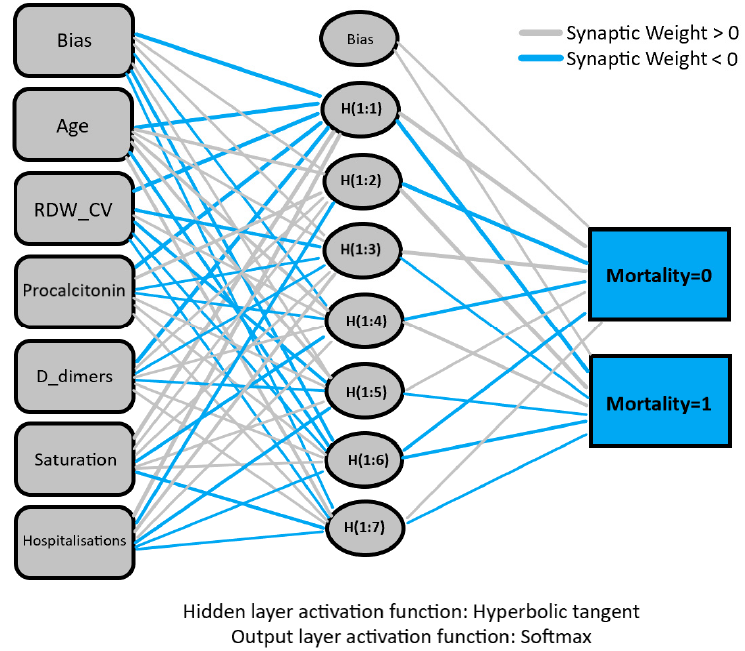
Figure 2. Network diagram acquired with multilayer perceptron multilayer model.